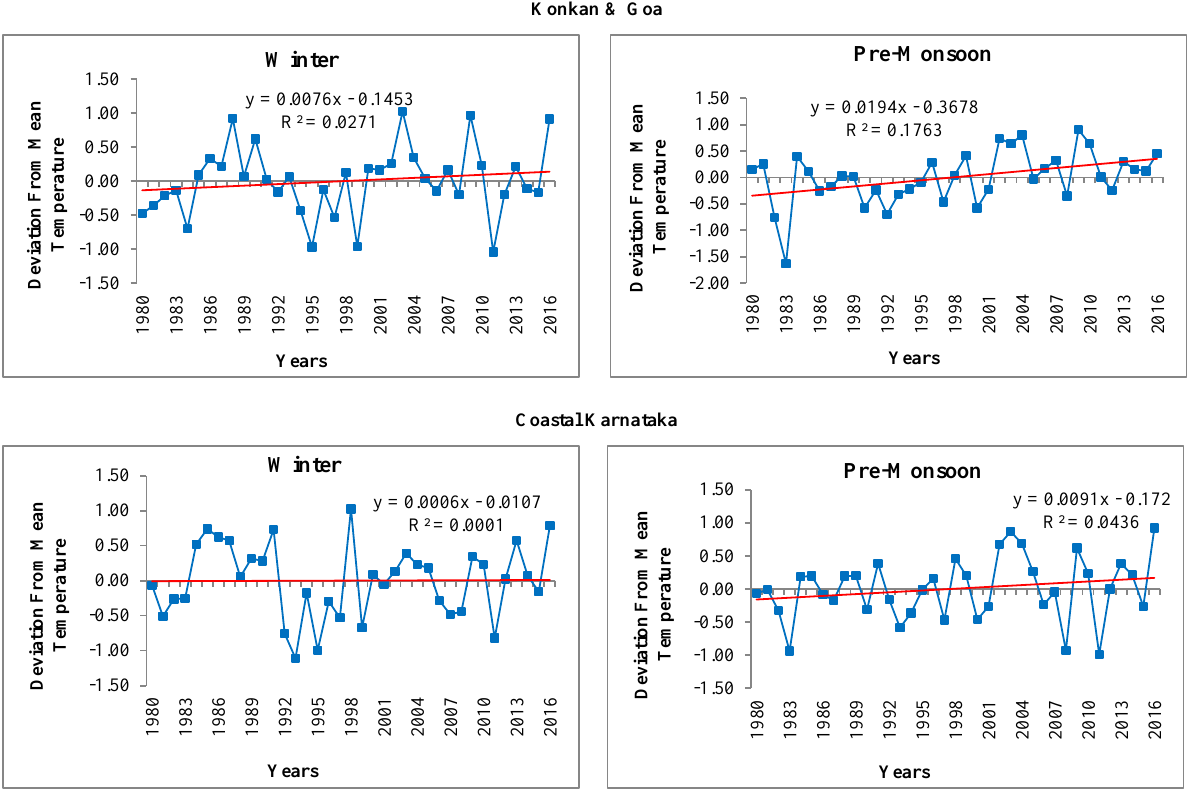
Figure 9. Trends in temperature of winter and pre-monsoon over both the